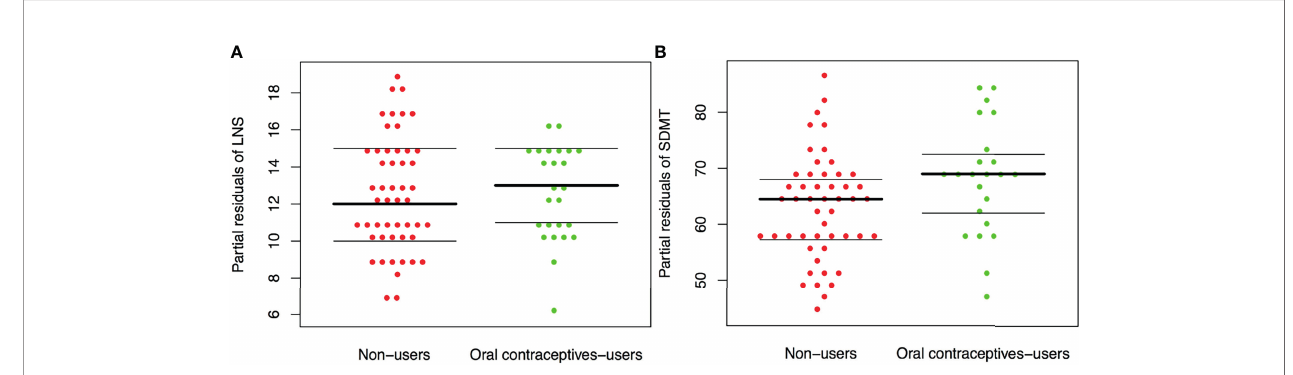
FIGURE 5 | (A, B) Working memory in oral contraceptive users versus non-users. Boxplot showing partial residuals of working memory test to remove the effect of age and education based on a generalized least square model. Working memory was tested with the Letter-Number-Sequencing (LNS) (A) test and the Symbol- Digit-Modalities-test (SDMT) (B) in oral contraceptive-users (OC-users) and women using no oral contraceptives (non-users). There was no difference between OC- users and non-users on the LNS (p = 0.9), but a trend towards better performance in OC-users was observed on the SDMT (p = 0.14). WM, working memory; LNS, Letter-number-sequence test; SDMT, Symbol-Digit-Modalities test; OC, oral contraceptive; CAR, cortisol awakening